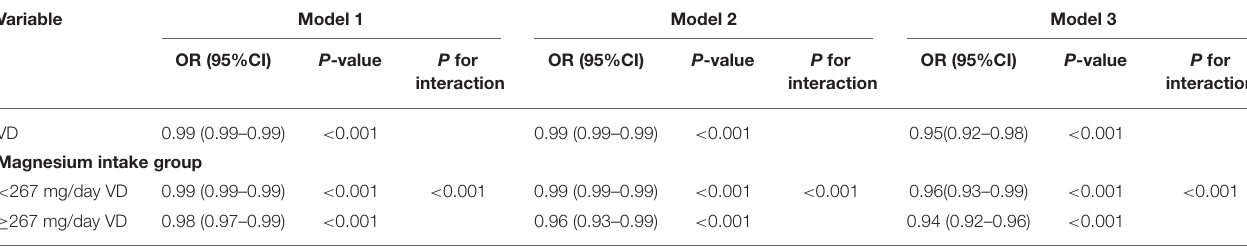
TABLE 4 | Interactive effect of vitamin D and dietary magnesium intake on Beta cell function is impaired.